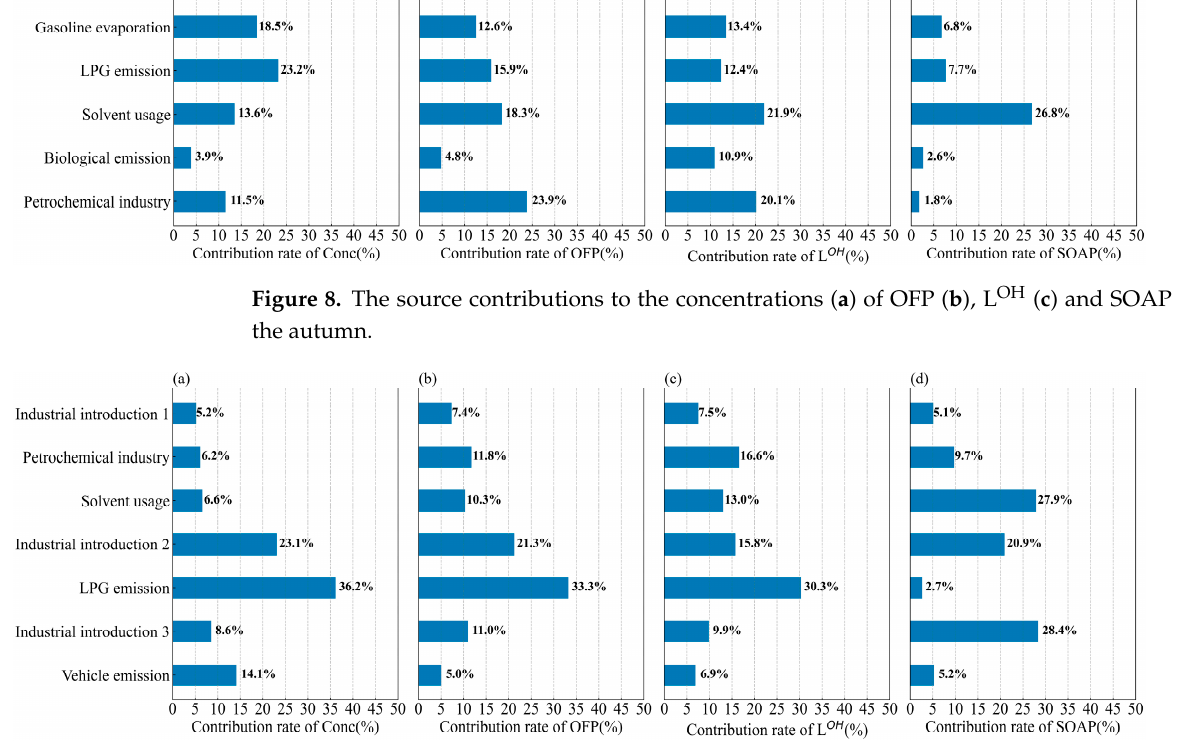
Figure 9. The source contributions to the concentrations ( a ) of OFP ( b ), L OH ( c ) and SOAP ( d ) in the winter.